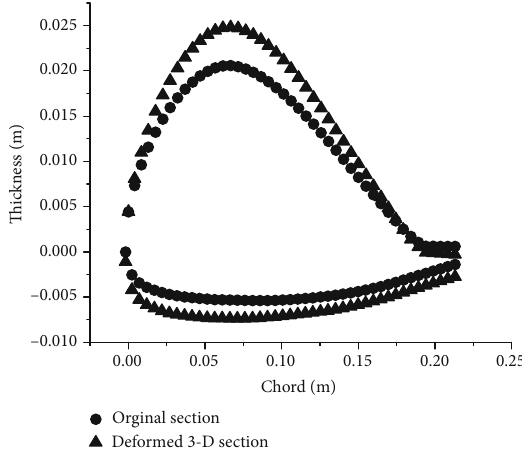
Figure 17: Deformed section of 3-D model ( AR = 12 : 5